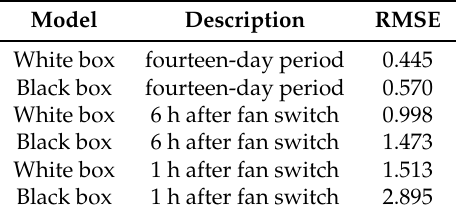
Table 3. Model accuracy